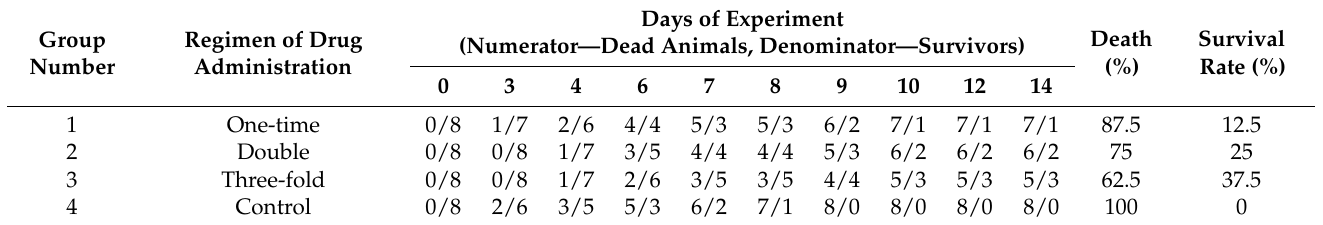
Table 4. Determination of the effectiveness in the model of staphylococcal sepsis in mice after repeated administration of drug 1 at a dose of 3 mg/kg.